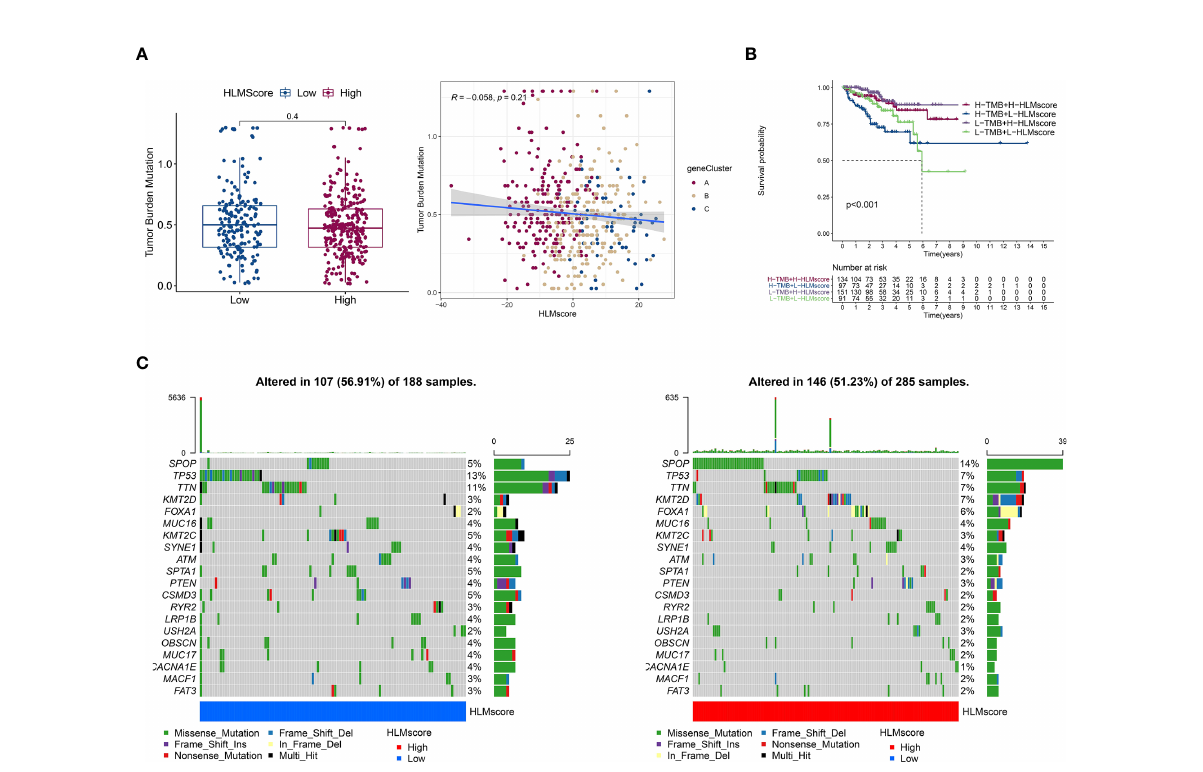
FIGURE 8 Characteristics associated with TCGA-PRAD tumor mutations based on HLMscore status. (A) (left) TMB values of the two HLMscore groups. The P value of the Wilcoxon test is shown in the boxplot. (right) Spearman correlation analysis between the HLMscores and TMB values in TCGA- PRAD was performed and is shown as a scatter diagram. Red, orange, and blue dots represent geneClusters A to C, respectively. (B) TCGA- PRAD patients were divided into two statuses (low and high TMB) according to the optimum threshold segmentation of TMB values in relation to the RFS analysis. Then, the TCGA-PRAD patients were further split into four groups based on TMB and HLMscore status (high (H)-TMB + H- HLMscore; H-TMB + low (L)-HLMscore; L-TMB + H-HLMscore; and L-TMB + L-HLMscore), and survival analysis for RFS was performed. (C) The somatic mutations of TCGA-PRAD patients with low-HLMscore (left) and high-HLMscore (right) groups are shown as waterfall